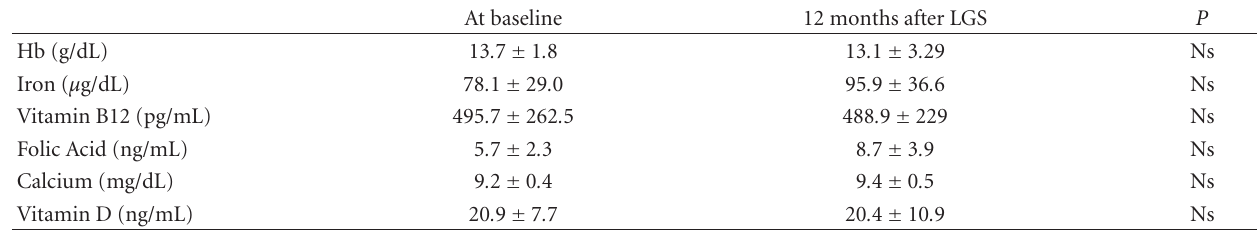
Table 2: Nutritional parameters before and after 12 months in all the patients.